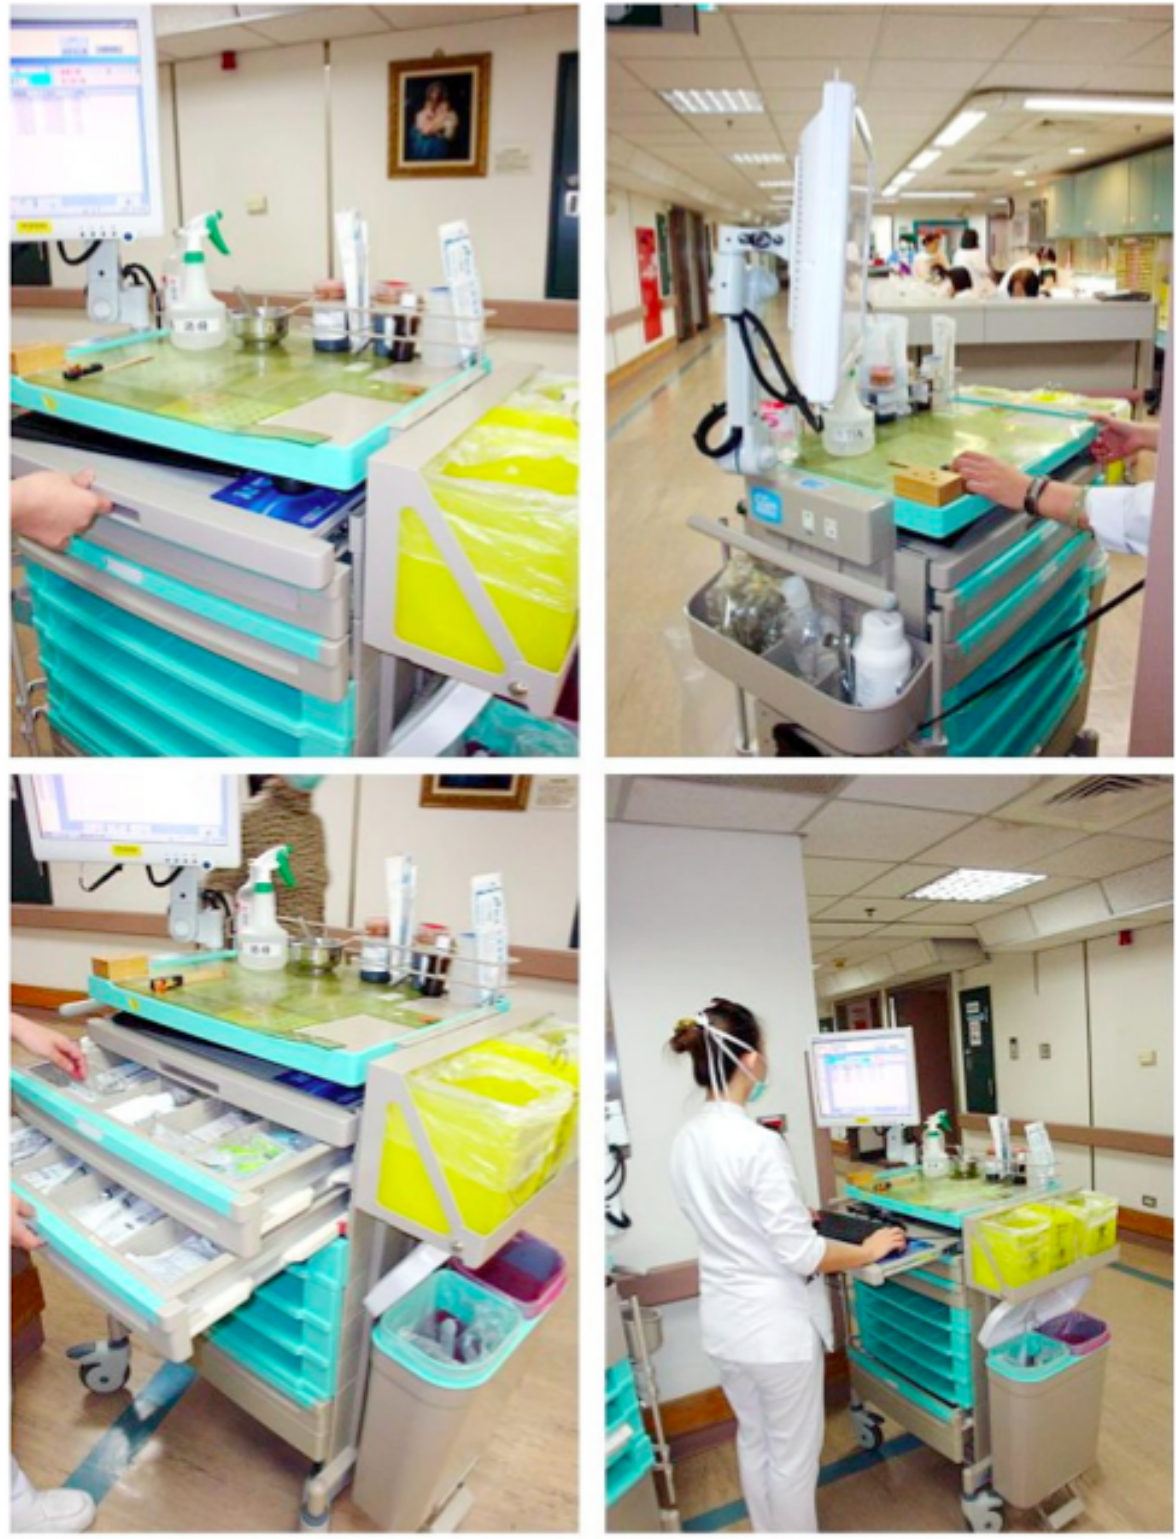
Figure 1. Using a wireless computer on wheels (COW) to collect data on patients’perspectives on